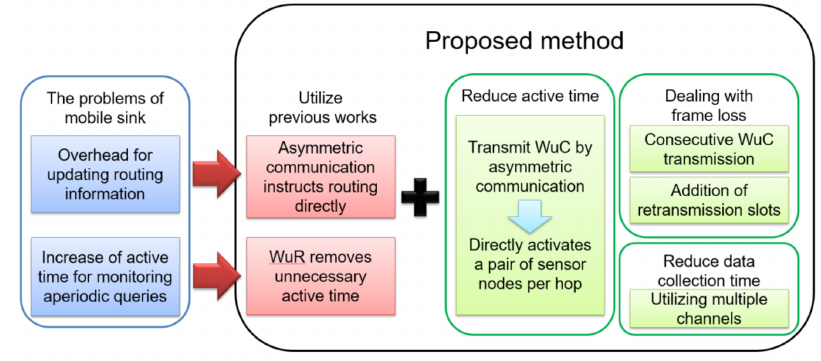
Figure 2. Conceptual diagram of the proposed method. WuR = wake-up radio; WuC = wake-up